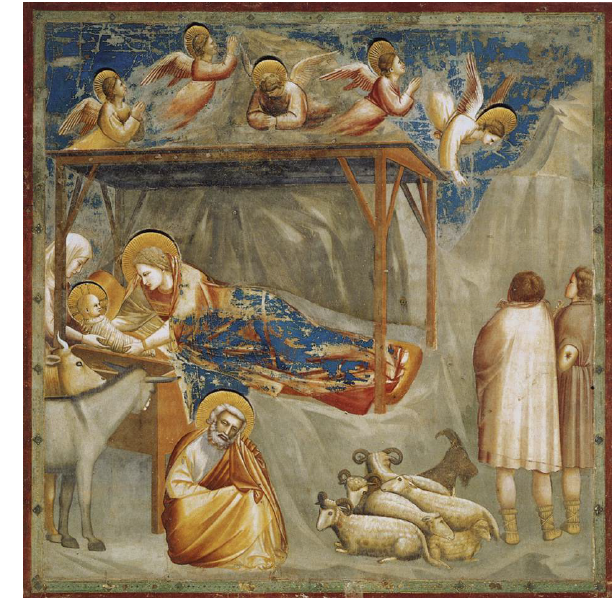
Figure 9. Nativity by Giotto (1303–1306 CE) at the Scrovegni (Arena) Chapel, Padua, Italy. Source: public domain – Wiki Com- mons.